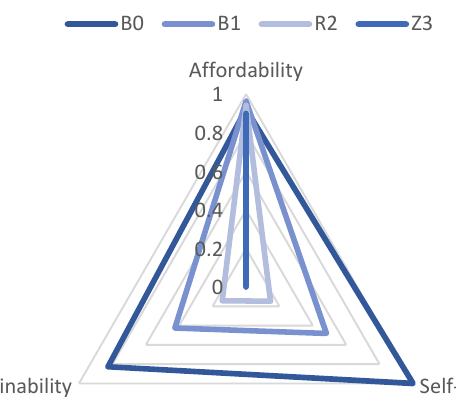
Figure 16. Comparing main RES deployment